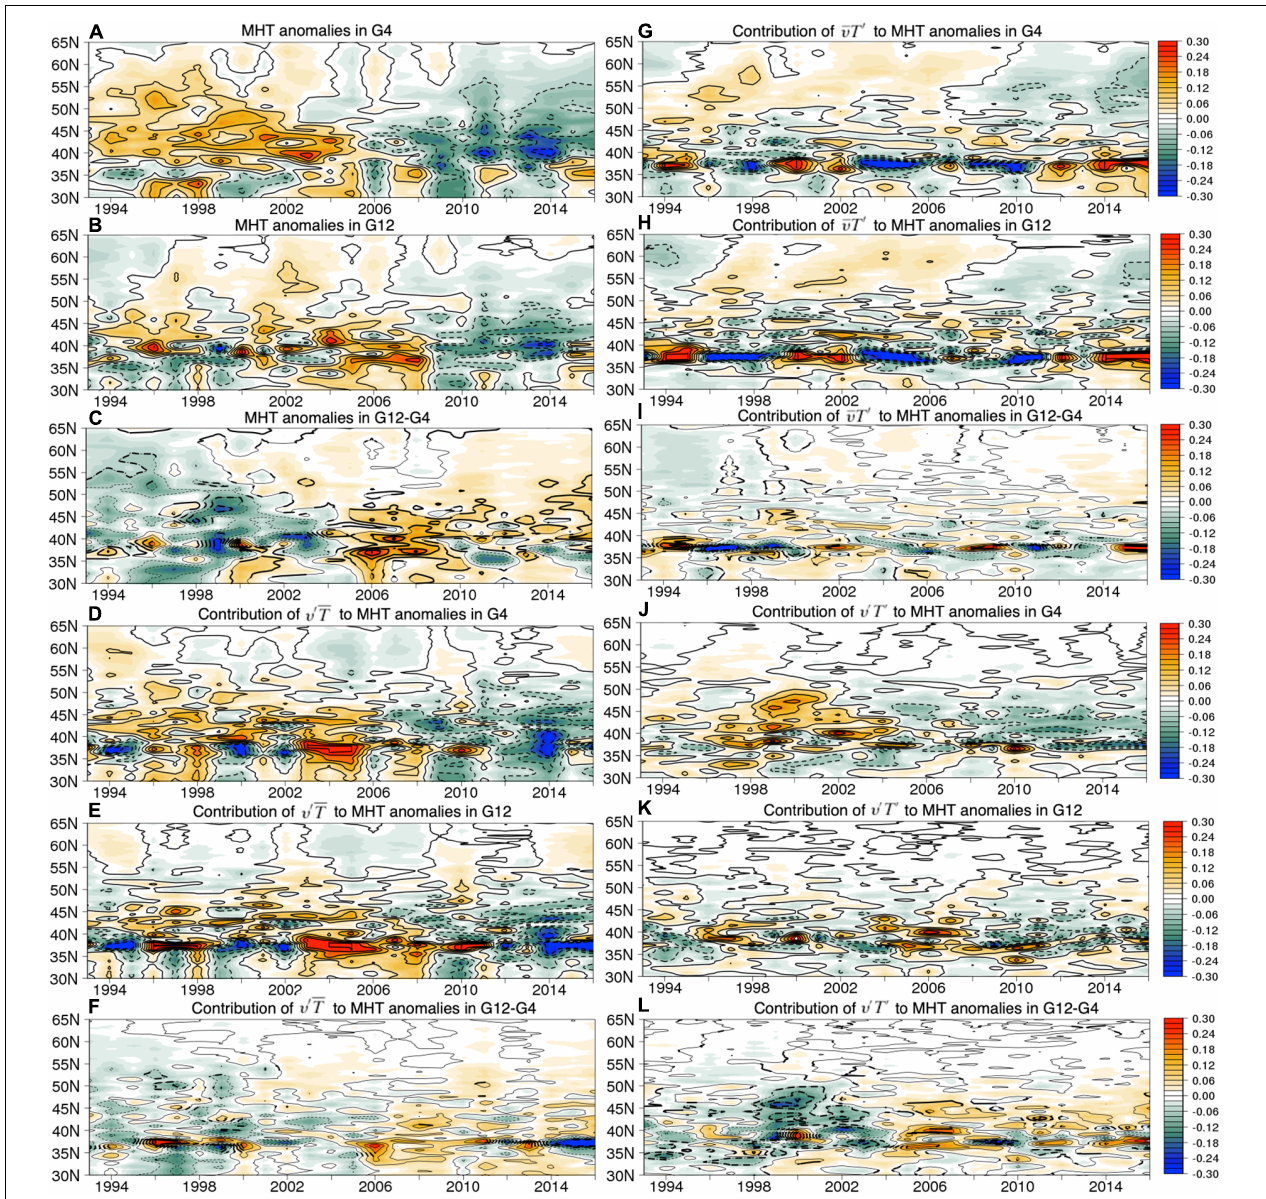
FIGURE 5 | Meridional heat transport anomaly vT − vT and decomposition v (cid:48) T , v T (cid:48) , ( v (cid:48) T (cid:48) − v (cid:48) T (cid:48) ) in G4 (A,D,G,J) and in G12 (B,E,H,K) calculated with 5-day data. (unit: PW) The differences between G12-G4 are shown in panels (C,F,I,L) , and areas with values that pass t -test 95% confidence interval are indicated in thick